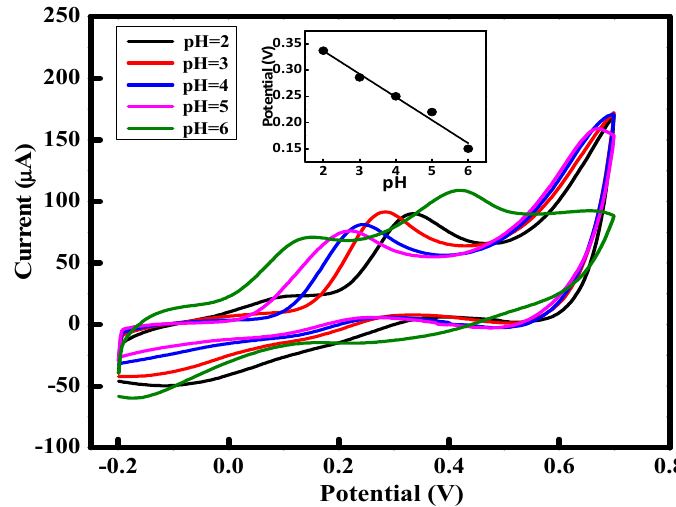
Figure 6. pH effect on the oxidative-current peak of the PANI electrode in AA solution (4mM). at 50 mVs -1 .